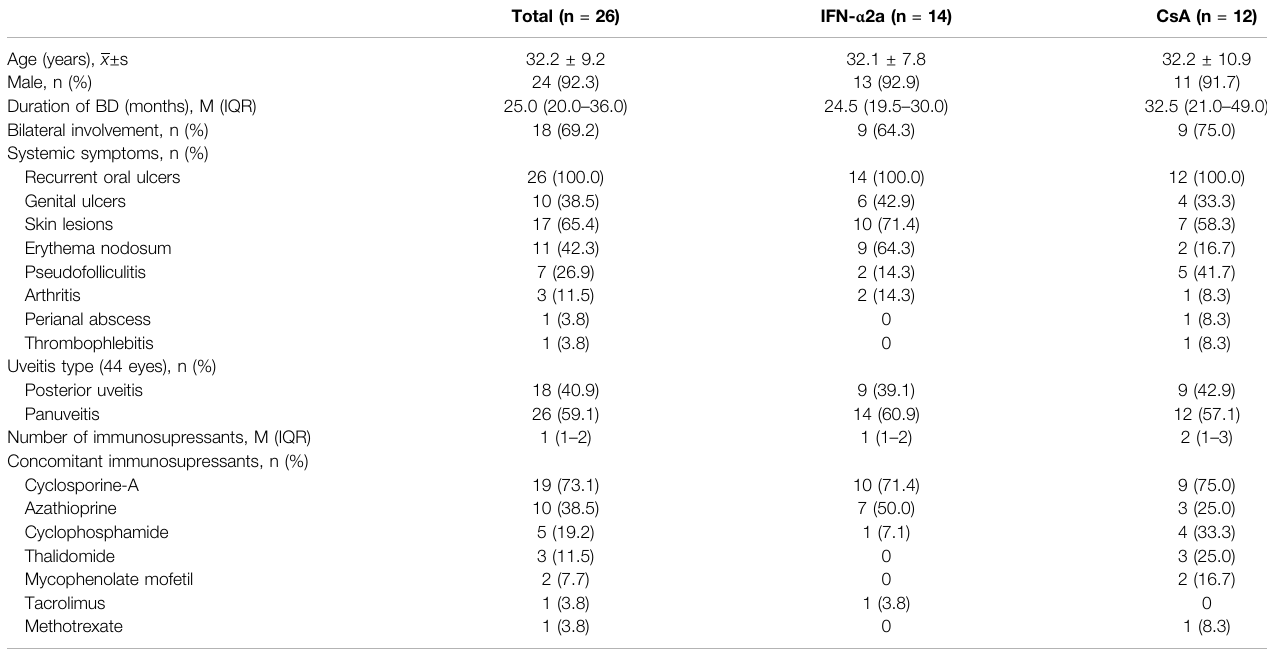
TABLE 1 | Baseline features of 26 patients with refractory BU.